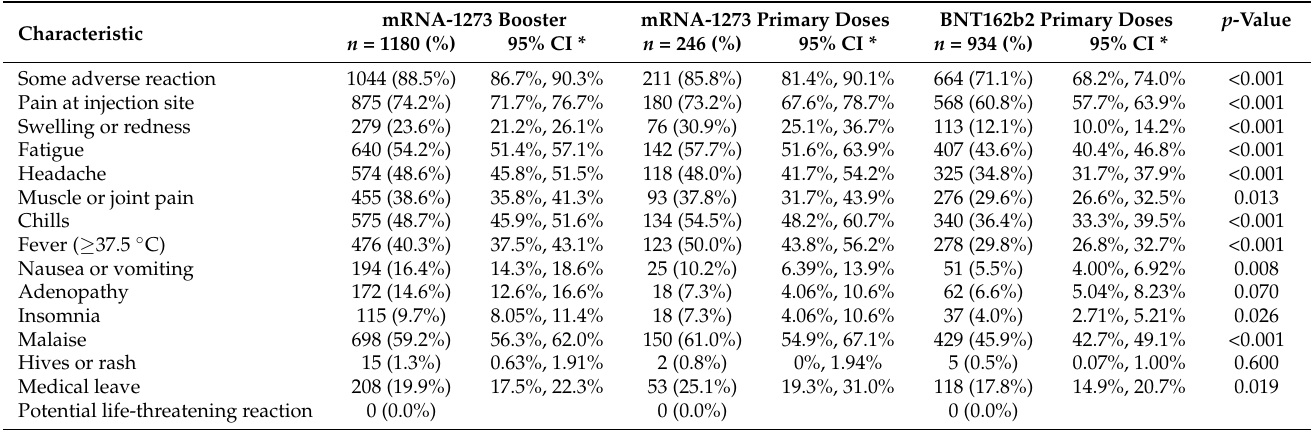
Table 2. The self-reported adverse reactions to the COVID-19 vaccination when comparing the primary doses versus the